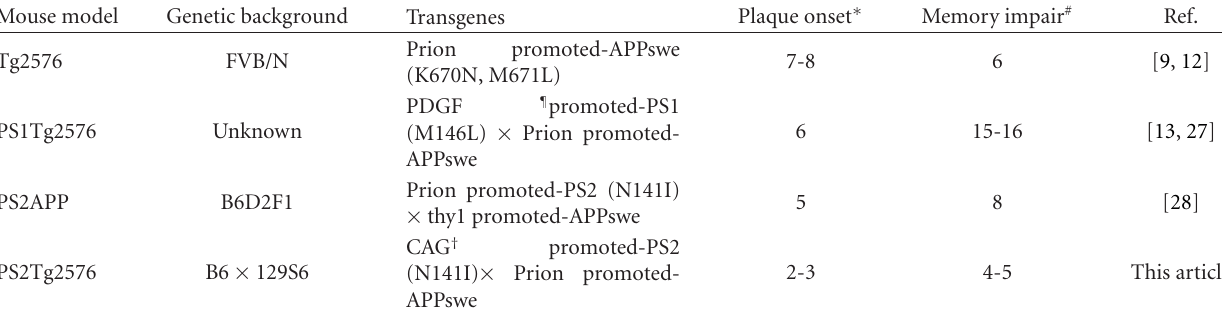
Table 2: Comparison of AD-like phenotypes in transgenic mouse